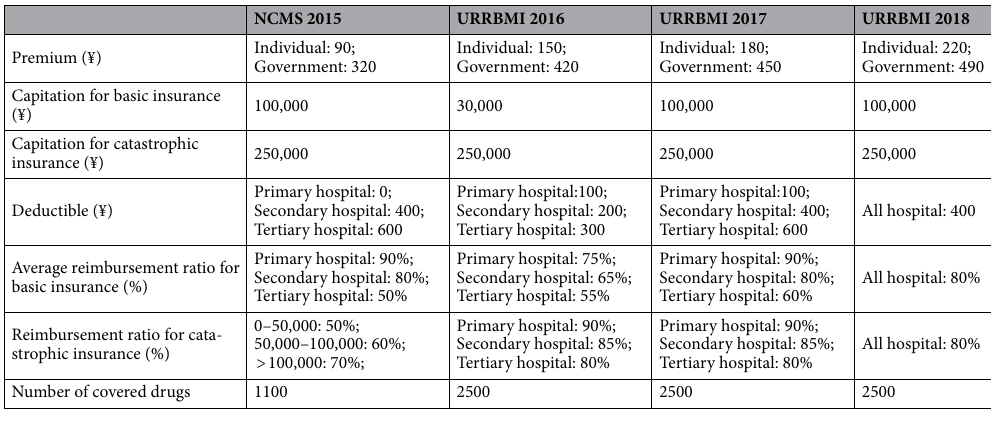
Table 1. Comparison of NCMS and URRBMI between 2015 and